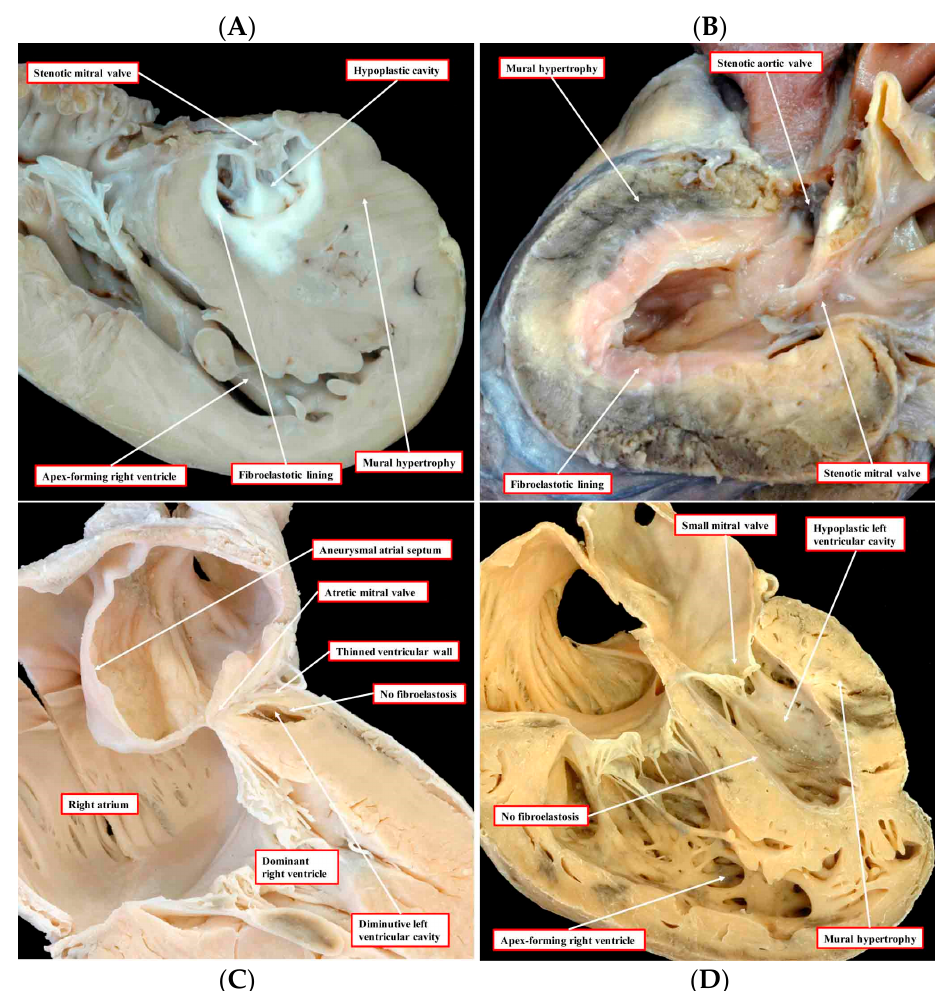
Figure 1. The images, all photographed by Diane E. Spicer and reproduced with her permission, show the phenotypic variants of hypoplastic left heart syndrome as seen in the clinical setting. The upper left panel ( A ) shows the variant with mitral stenosis and aortic atresia. The heart in the upper right-hand panel ( B ) has mitral and aortic stenosis. In the lower panels, to the left ( C ) is seen the variant with mitral atresia, and to the right ( D ) is the rarest variant with left ventricular hypoplasia with the small aortic and mitral valves, their size in keeping with that of the left ventricle, although the aortic valve is not seen in the four-chamber section through the heart [1].